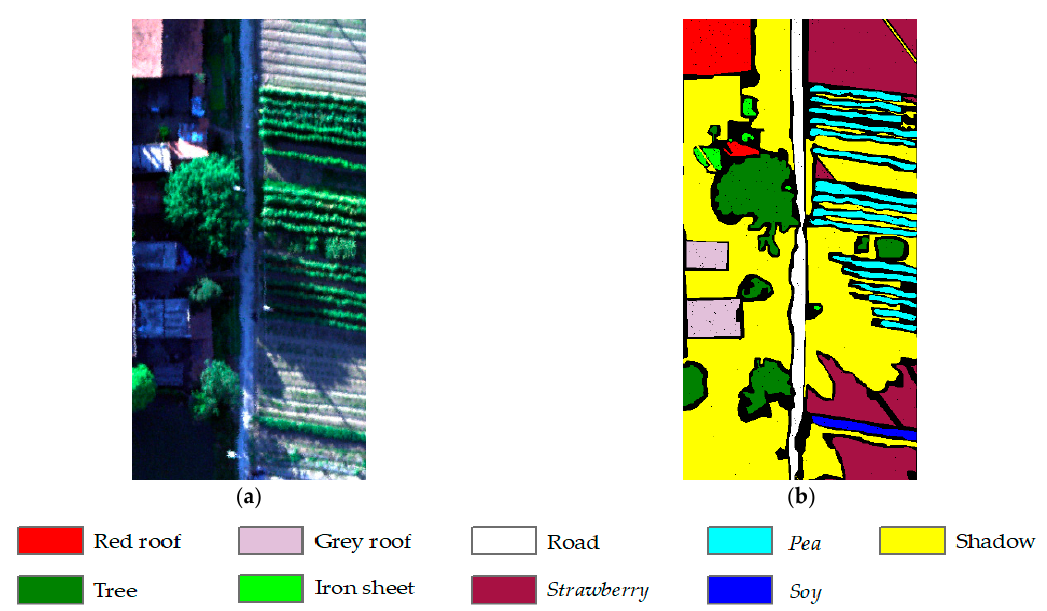
Figure 5. The Hanchuan dataset: ( a ) the true-color image; ( b ) the ground-truth Figure 5 . The Hanchuan dataset: ( a ) the true-color image; ( b ) the ground-truth map. Table 2. The training and test sample information for the Hanchuan dataset.